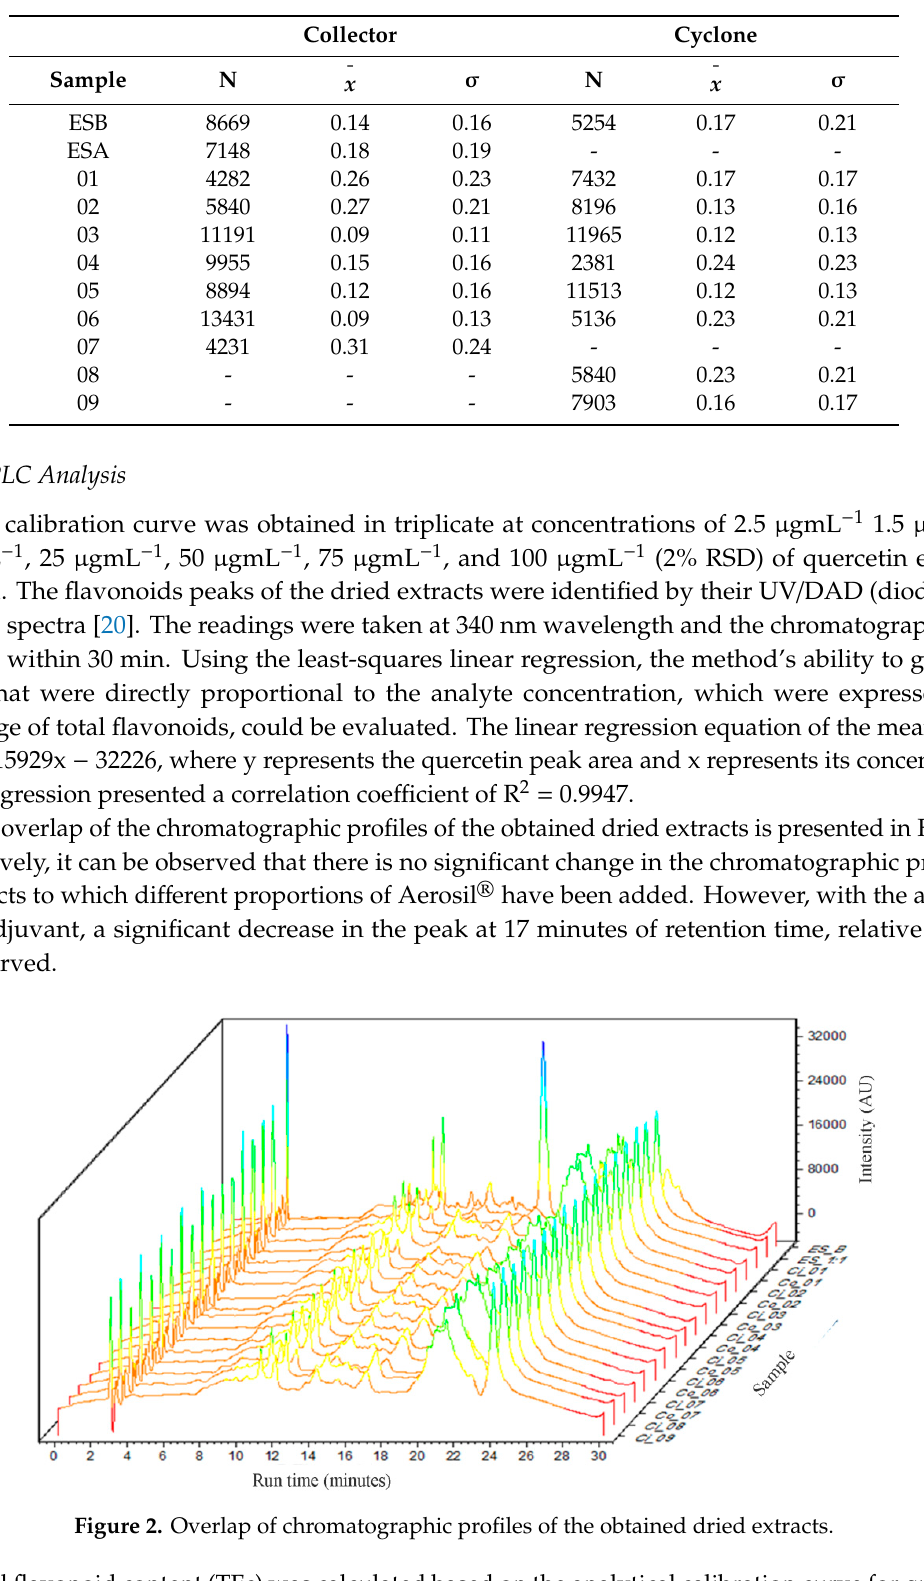
Table 1. Number of particles (N), average values (x), and standard deviation ( σ ) of particle areas identified and calculated by ImageJ ® software.